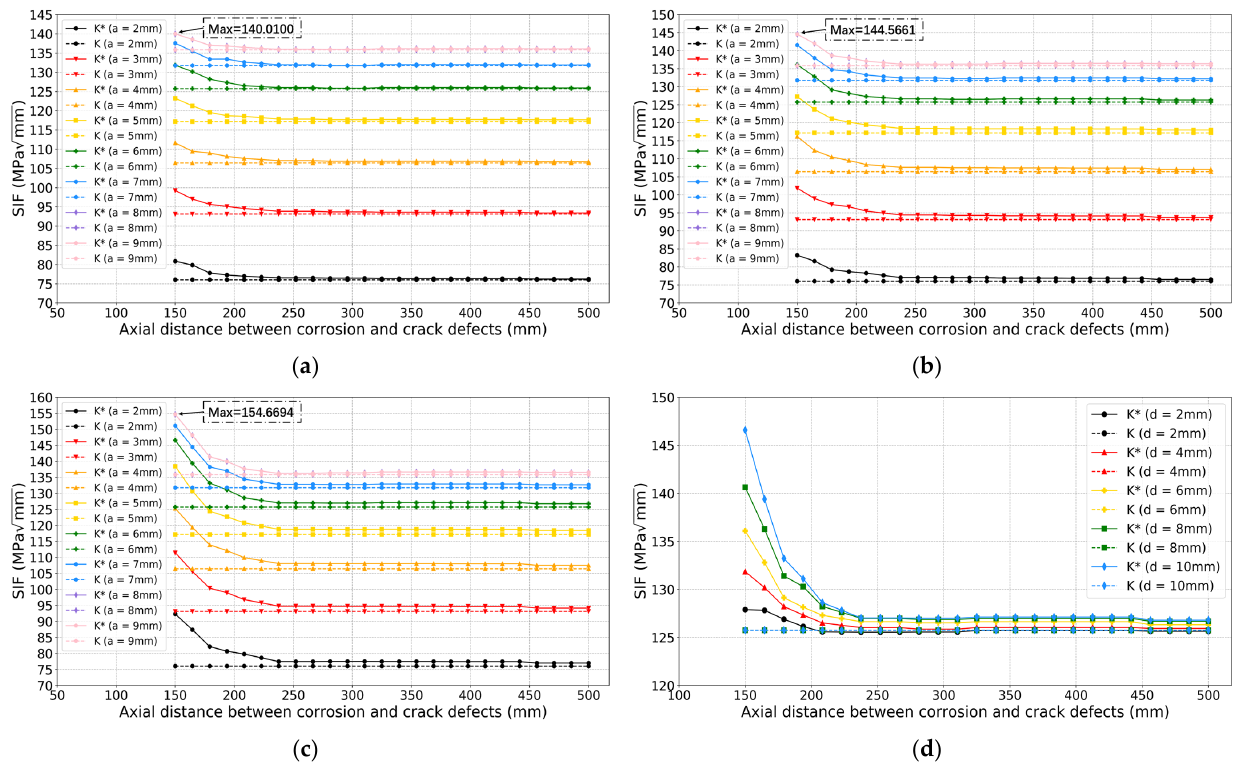
Figure 12. The comparison of SIF results based on approach 2. Corrosion depth d : ( a ) 4 mm; ( b ) 6 mm; ( c ) 10 mm; ( d ) Comparison results for different corrosion depths when crack depth a is 6